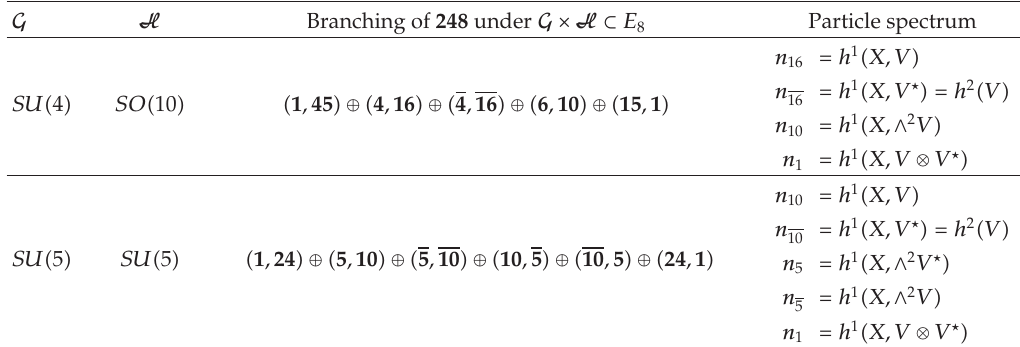
Table 1: A vector bundle V with structure group G (cid:2) SU (cid:5) 4 (cid:6) or SU (cid:5) 5 (cid:6) , respectively, breaks the E of the heterotic string into the Grand Unifying group H (cid:2) SO (cid:5) 10 (cid:6) or SU (cid:5) 5 (cid:6) . The four-dimensional low- energy representation contents of H arise from the branching of the 248 adjoint of E 8 under G × H ⊂ E 8 . The particle spectrum is obtained as various bundle-valued cohomology